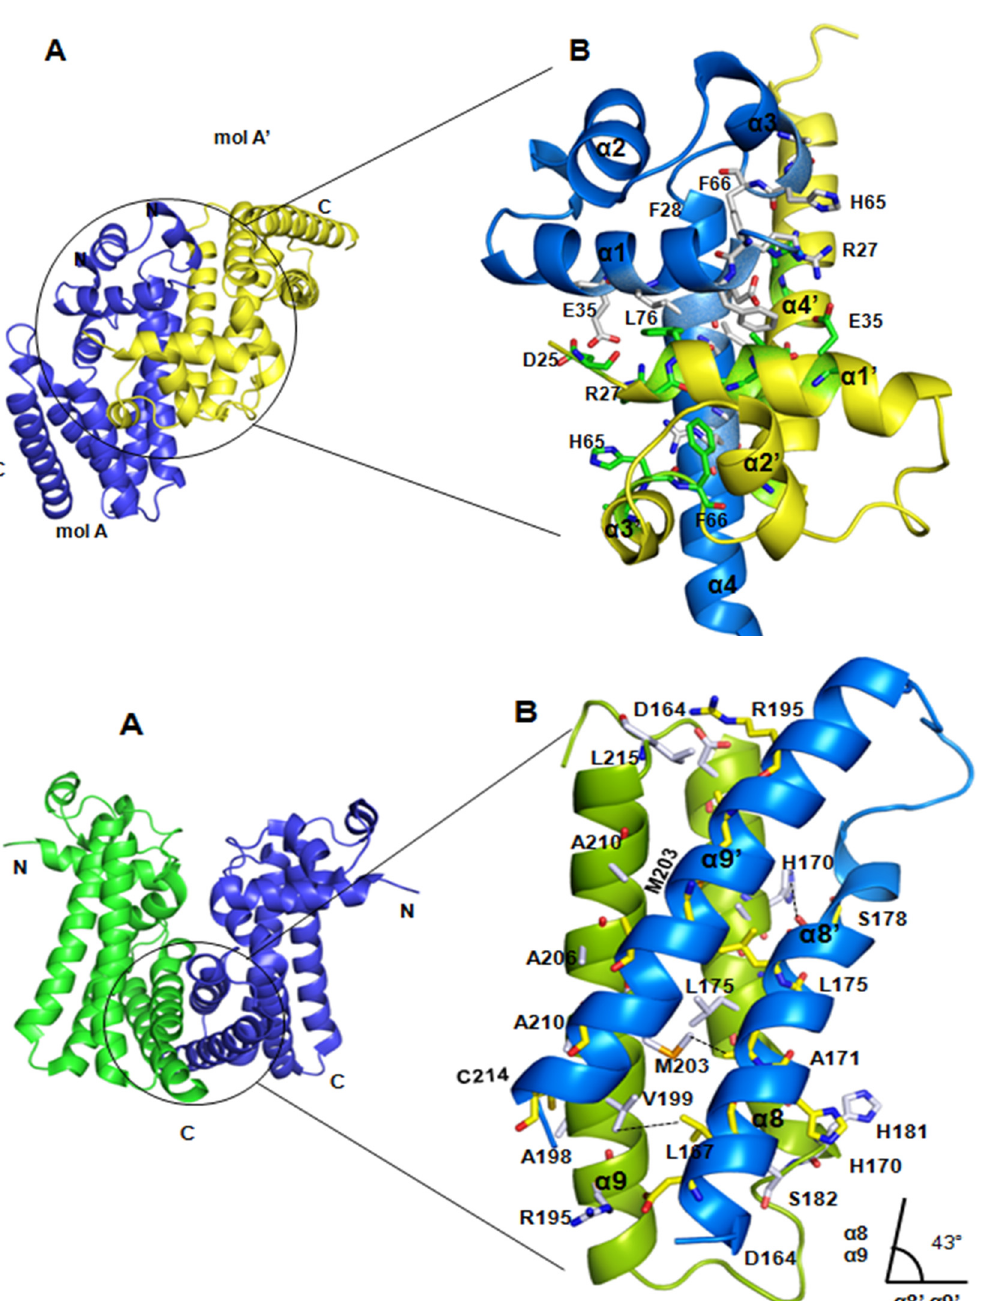
Fig 4. Structural view of dimerization interfaces. A) The canonical dimer (blue and green) found in the asymmetric unit. Two dimerization helices ( α 8, α 9 and α 8 ’ , α 9 ’ ) that form four helix bundle at the interface are shown. B) A close-up view of dimerization interface (cartoon) and important residues that make interactions are shown in sticks. The crossing angle between dimerization units is shown below. C) The alternative dimer formed between one monomer of the canonical dimer (molA, cyan) and one monomer of the symmetry mate (mol A', green). D) The dimerization interface of alternative dimer shows alternative dimerization interface is contributed by two DBDs ( α 1 and α